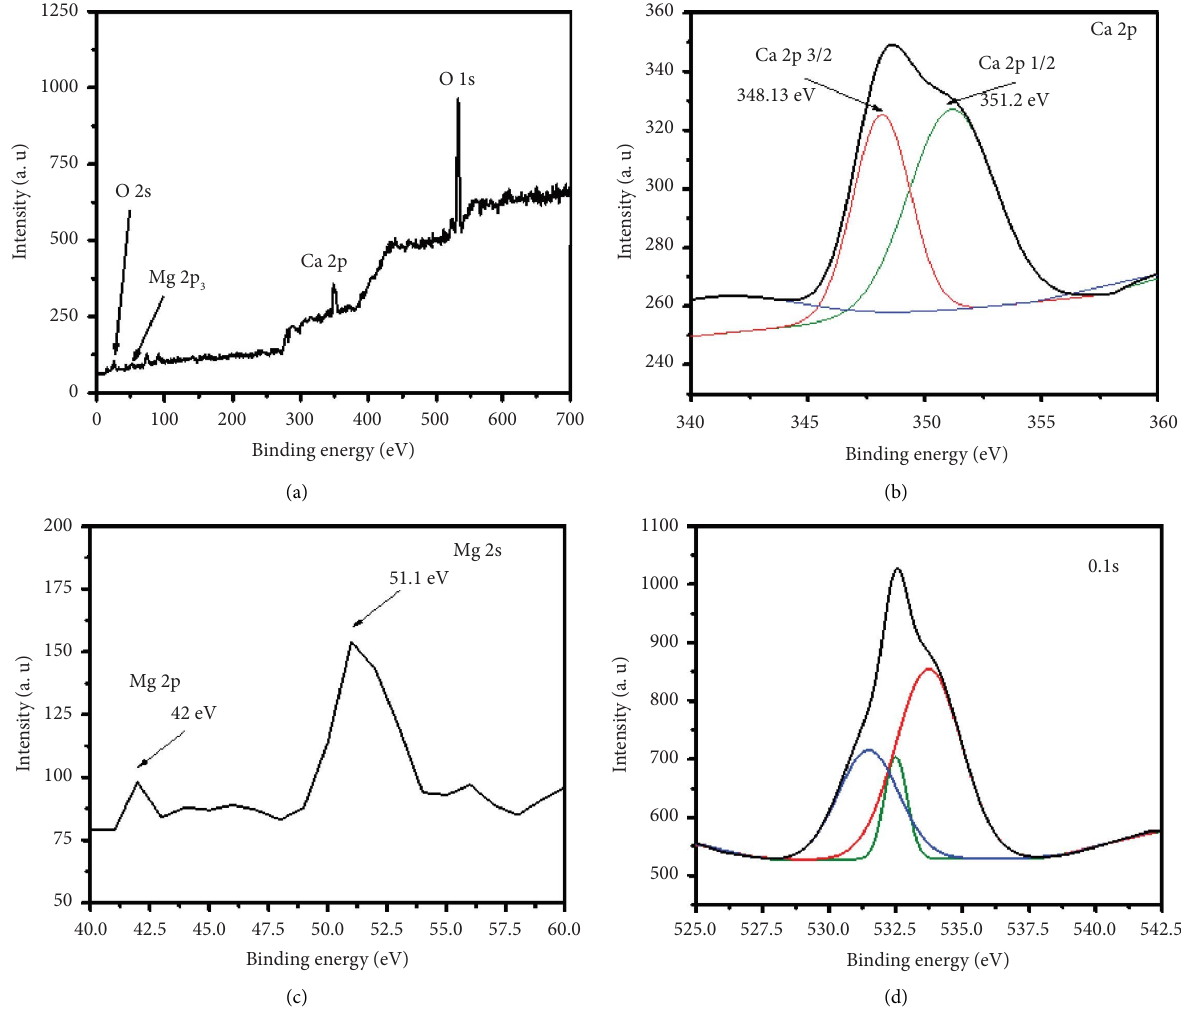
Figure 3: XPS spectra of (a) survey, (b) Ca-2p, (c) Mg-2p, and (d) O-1s for CaO.MgO nanosorbent.